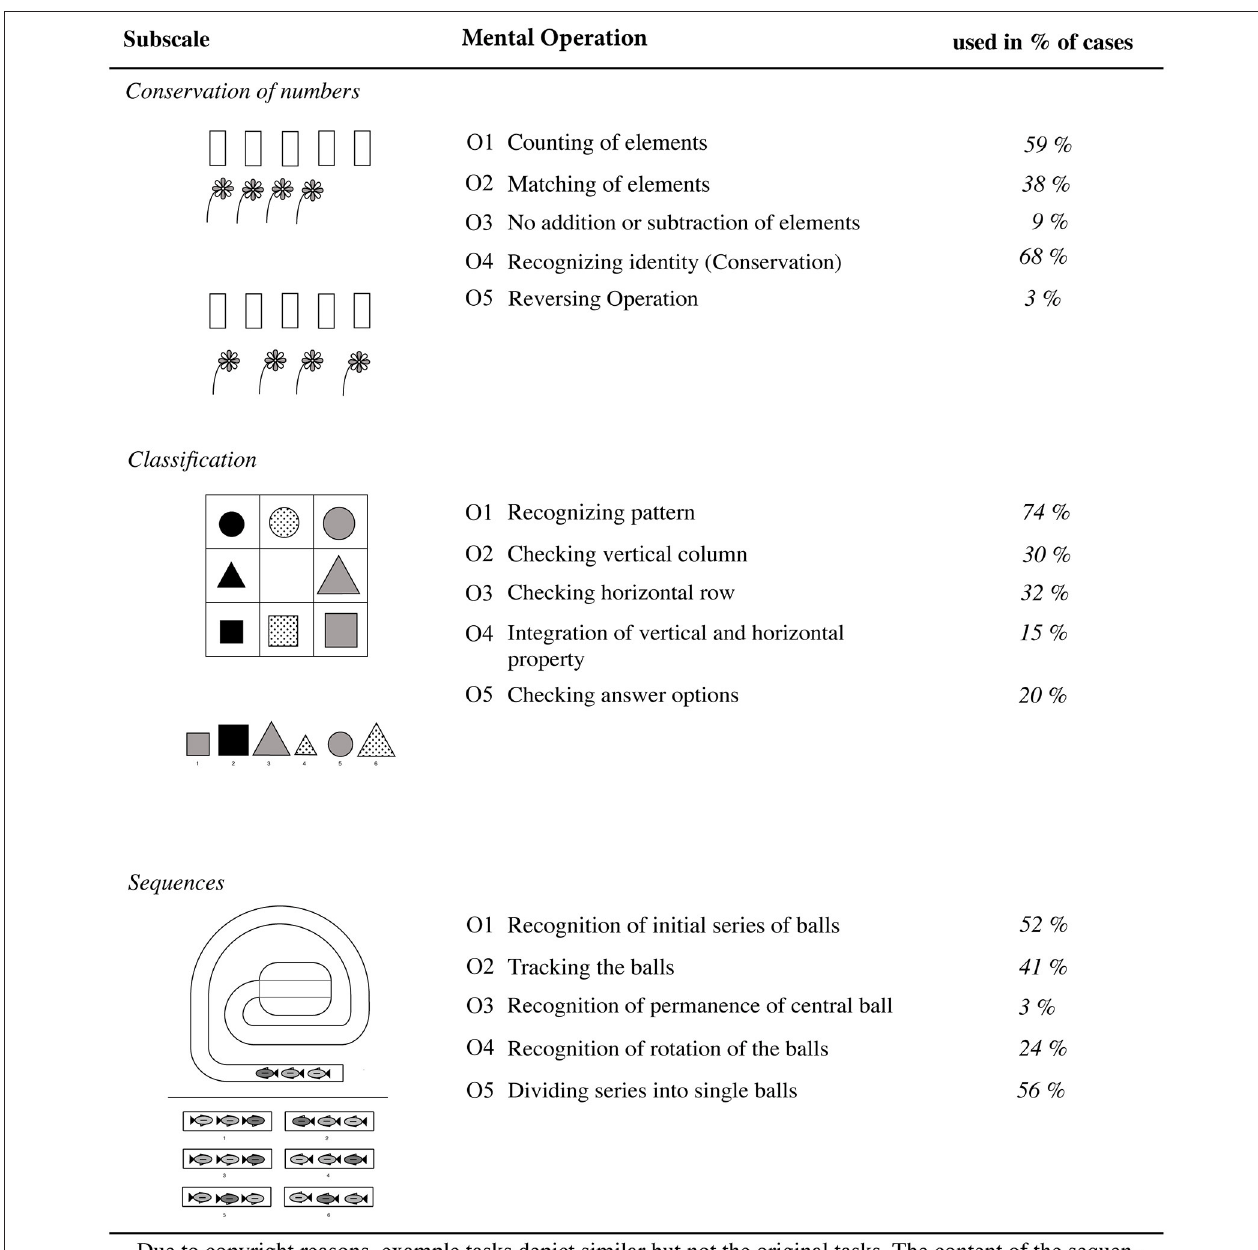
FIGURE 2 | Overview of the subscales and use of related strategic operations in conservation, classification and sequences tasks.